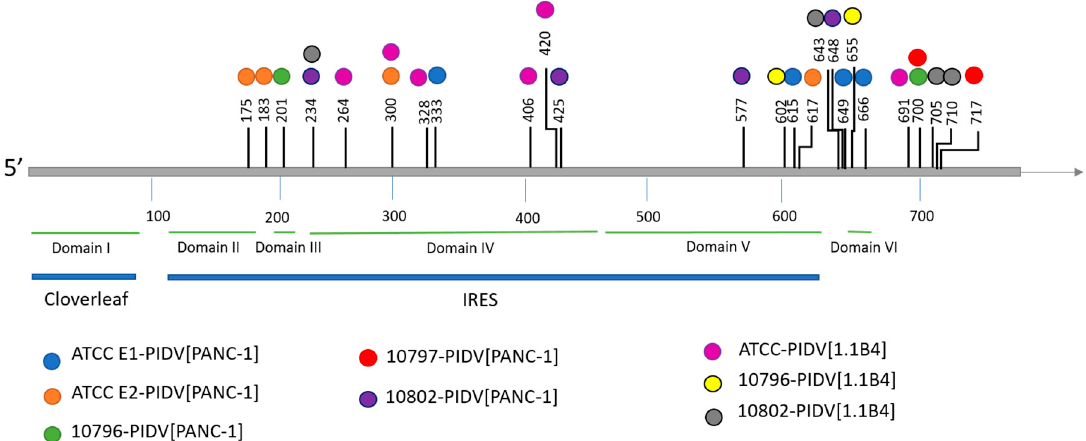
Figure 5. Mutation in 5 (cid:48) -UTR. SNPs are color coded indicating di ff erent PIDVs. Six distinct domains of the 5 (cid:48) -UTR are indicated by horizontal bars. Domain I is the cloverleaf structure and the IRES covers the domains II-V. Domain I: base pairs 2–87; Domain II: base pairs 105–181; Domain III: base pairs 189–209; Domain IV: base pairs 213–456; Domain V: base pairs 466–636 and Domain VI: base pairs 651–669